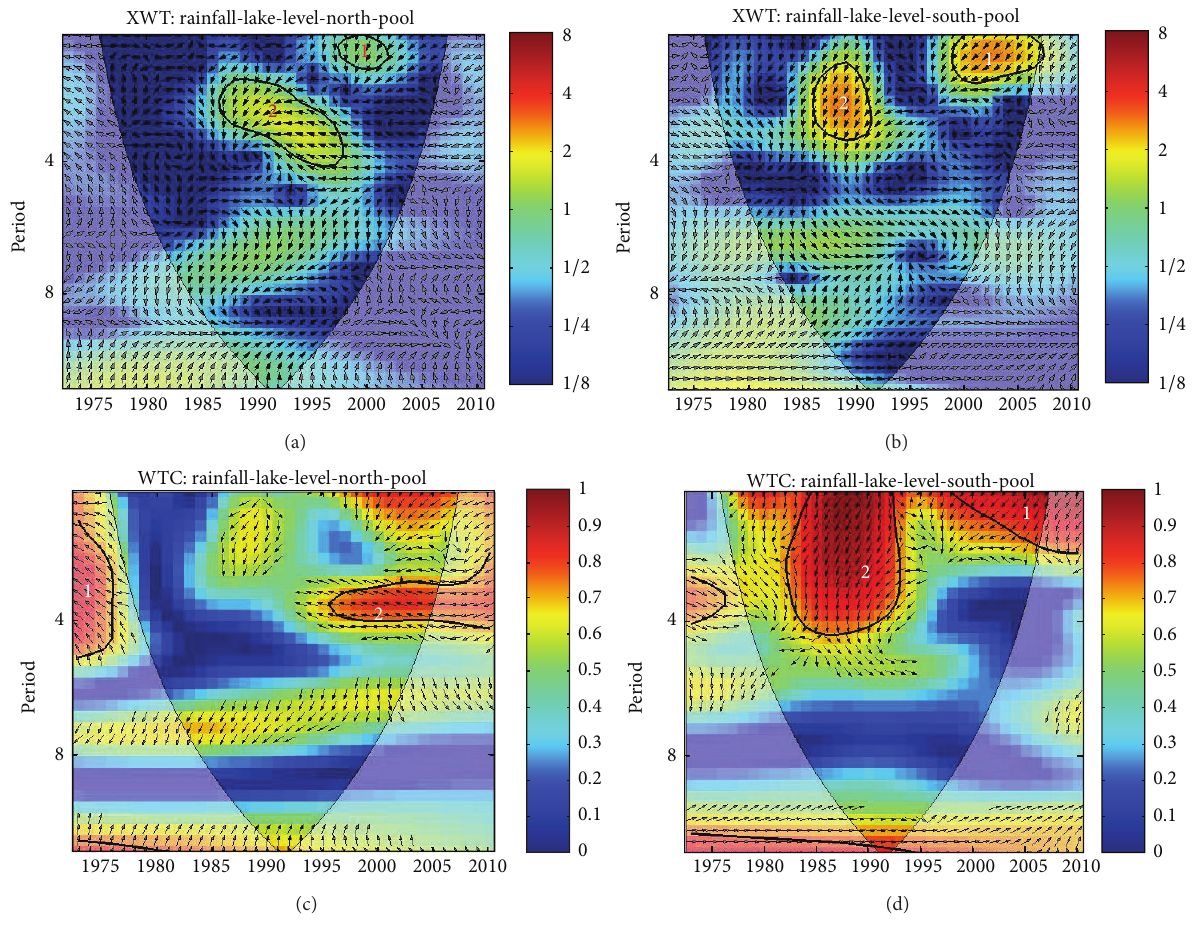
Figure 5: Precipitation and lake level cross-wavelet spectra: (a) northern LCB; (b) southern LCB and wavelet coherence; (c) northern LCB; and (d) southern LCB (in-phase pointing right, anti-phase pointing left, leading by 90 ∘ pointing straight down). The thick contour enclosed regions are greater than 95% confidence for a red-noise process. The thin solid line indicates the “cone of influence,” where edge effects become